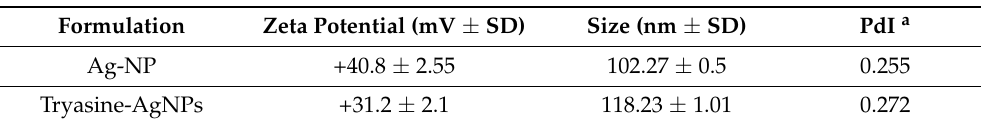
Figure 3. The color change before and after the reaction. ( A ) The color before, ( B ) the color after the reaction. Table 1. The characterization of AgNPs and Tryasine-AgNPs: Surface charge (zeta potential) and average size diameter.